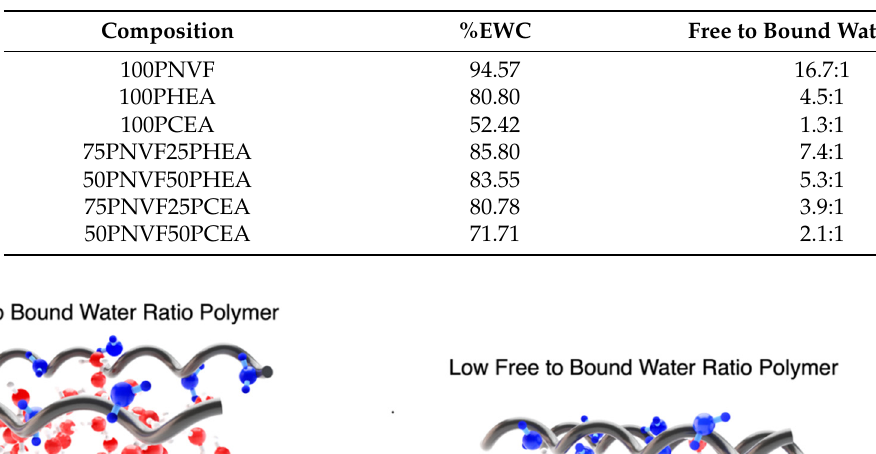
Table 2. %EWC and free to bound water ratio of the hydrogel samples.